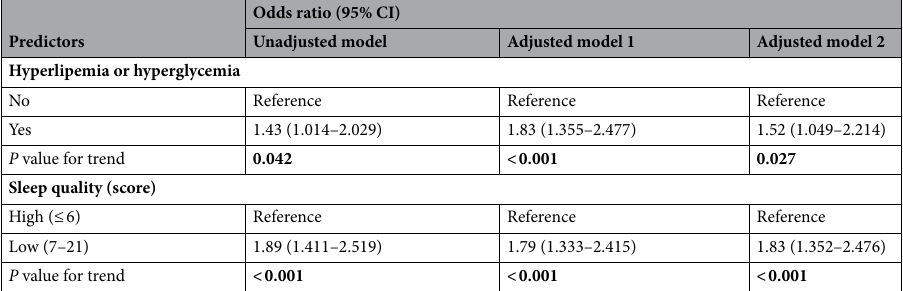
Table 3. Associations of hyperlipemia/hyperglycemia and PSQI with osteoarthritis. 95% CI 95% confidence interval. The prevalence of osteoarthritis was regarded as a dependent variable. Adjusted model 1 was adjusted for sex, age, and occupation; Adjusted model 2 was adjusted for variables included in model 1 and variables in Compliance. Significant differences ( P < 0.05) are highlighted in